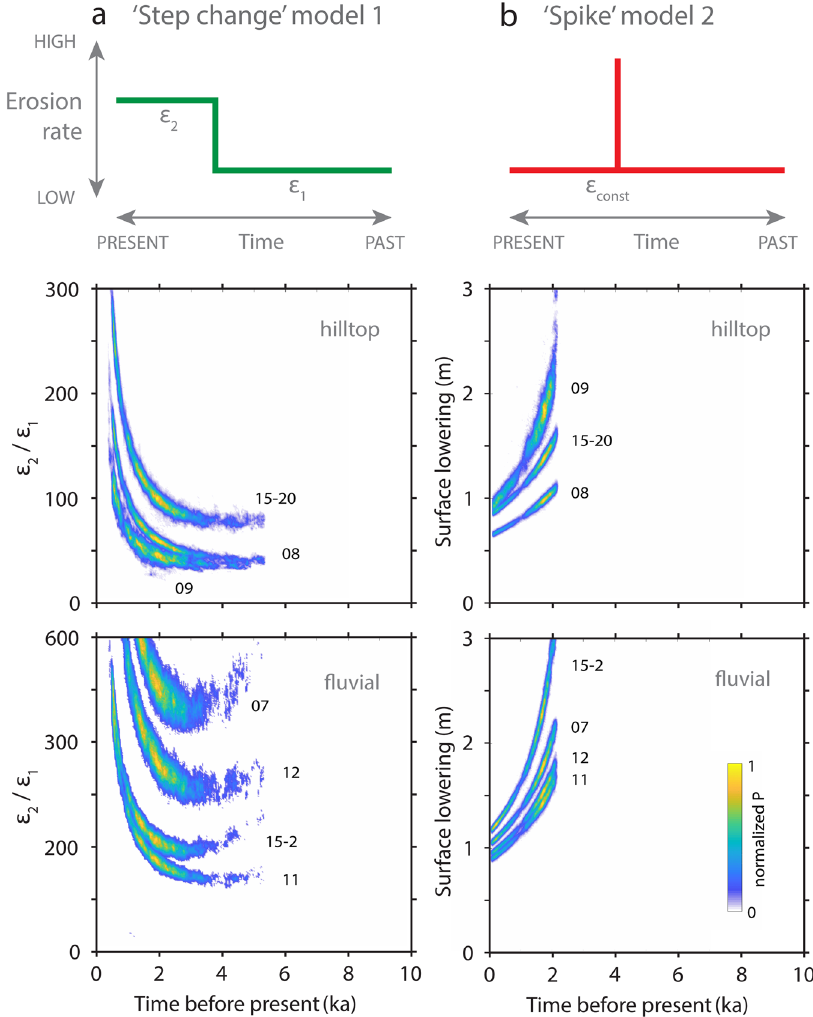
Fig. 4 Results of the MCMC inversion modelling of the two limiting-case scenarios. Model results are based on a joint inversion of three hilltop samples and four fl uvial samples that show a 14 C- 10 Be offset. We assume that all samples record the same timing of the perturbation but have variable bedrock- controlled past and present erosion rates. a The step model shows the ratio of present to past erosion rates ( ε 2 / ε 1 ) over time illustrating the possible timing and amplitude of erosion rate increase in the past. Note the change in scale of the y axis in the plot for the fl uvial samples, which indicates an overall larger amplitude of perturbation. b The spike model shows the possible magnitude of surface lowering (in m) over time. The colour ramp applies to all plots and shows the density of accepted models normalized to the highest value such that the most frequent results are denoted by P = 1. Both limiting-case scenarios indicate that a strong landscape perturbation occurred in the Late